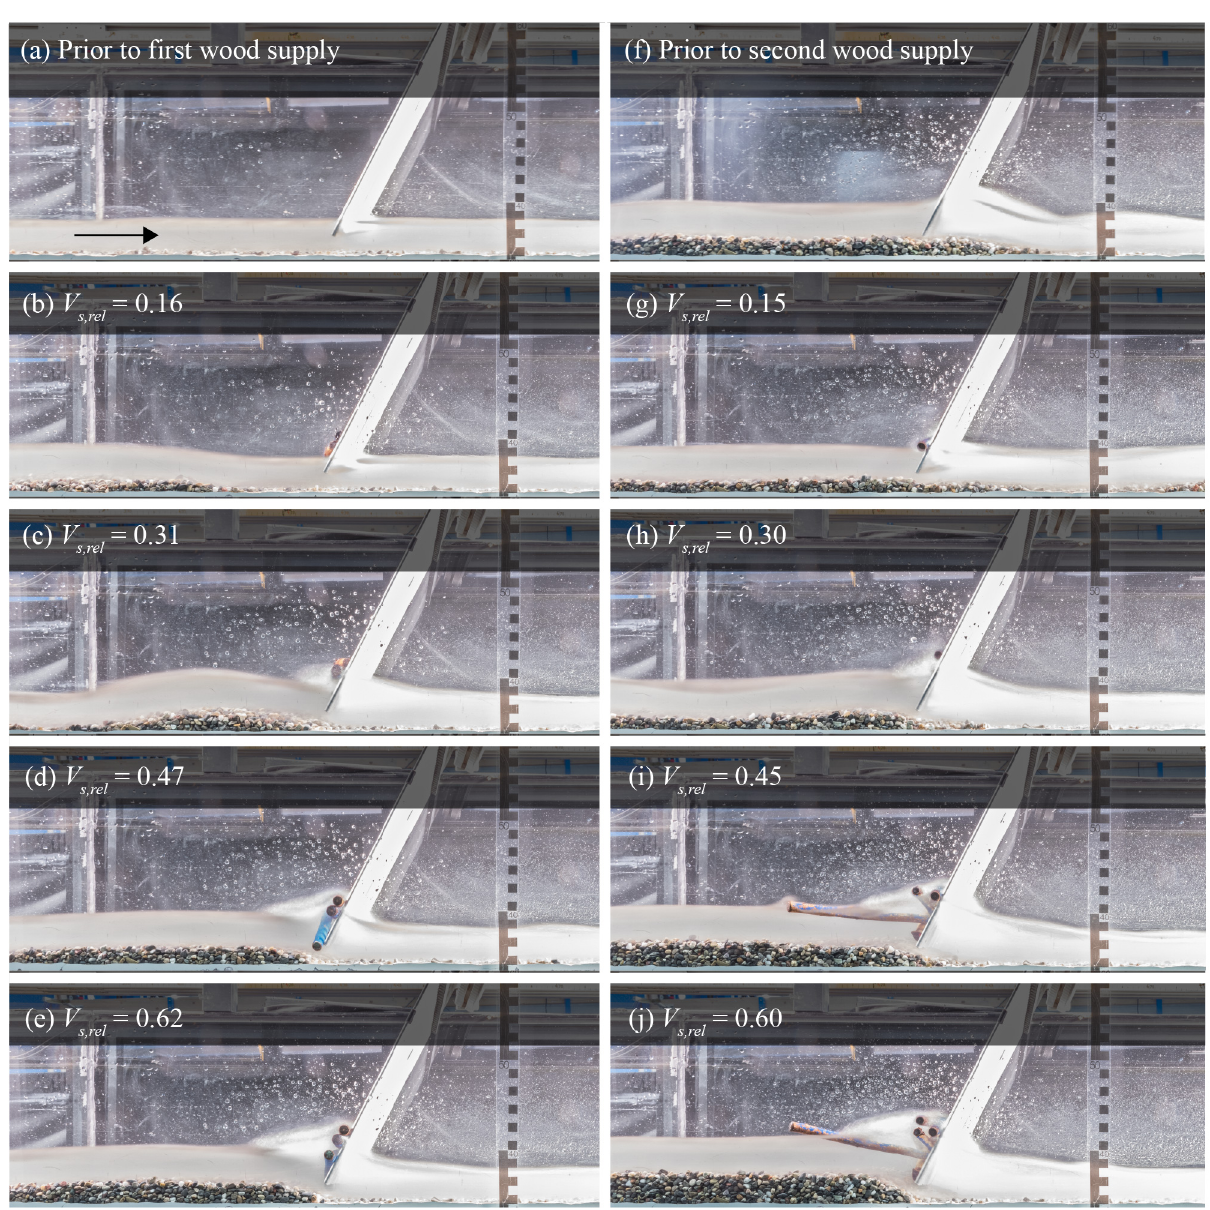
Figure 12. LW accumulation and bedload deposition at the inclined bar screen for test V15 with increasing V s , rel . Panels ( a – e ) illustrate first run and panels ( f – j ) second run. ( a ) Prior to first wood supply, ( b ) V s , rel = 0.16, ( c ) V s , rel = 0.31, ( d ) V s , rel = 0.47, ( e ) V s , rel = 0.62, ( f ) after wood removal of first run and prior to second wood supply, ( g ) V s , rel = 0.15, ( h ) V s , rel = 0.30, ( i ) V s , rel = 0.45, ( j ) V s , rel =